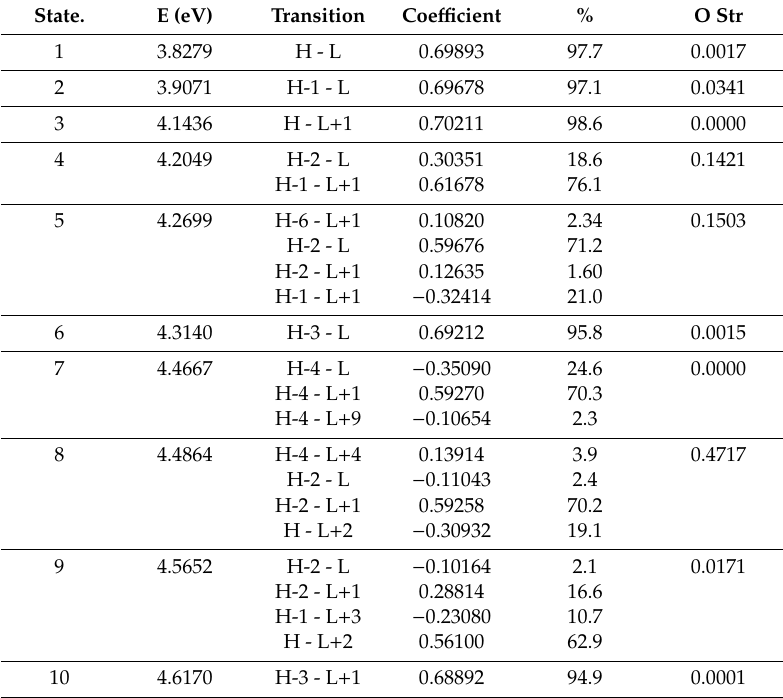
Figure 13. The four most important calculated energy transitions between the molecular orbitals of fluorescein in water. The main electronic configurations of each transition are shown.